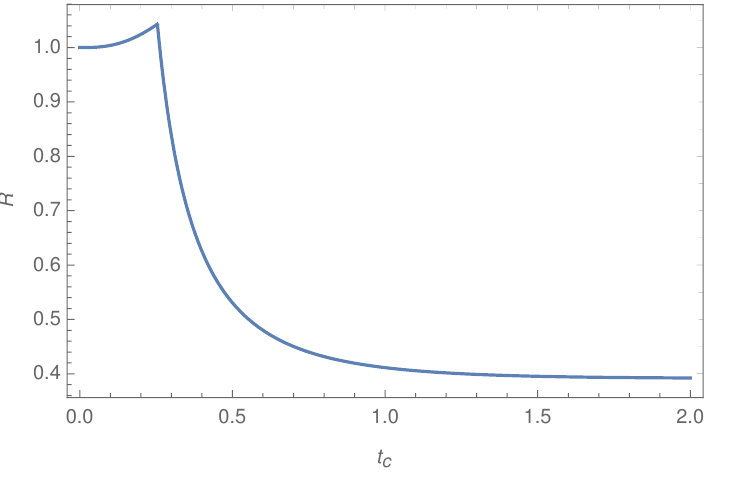
Figure 5 . The recombination factor of the same non-BPS black string(s) as a function of the critical value t c